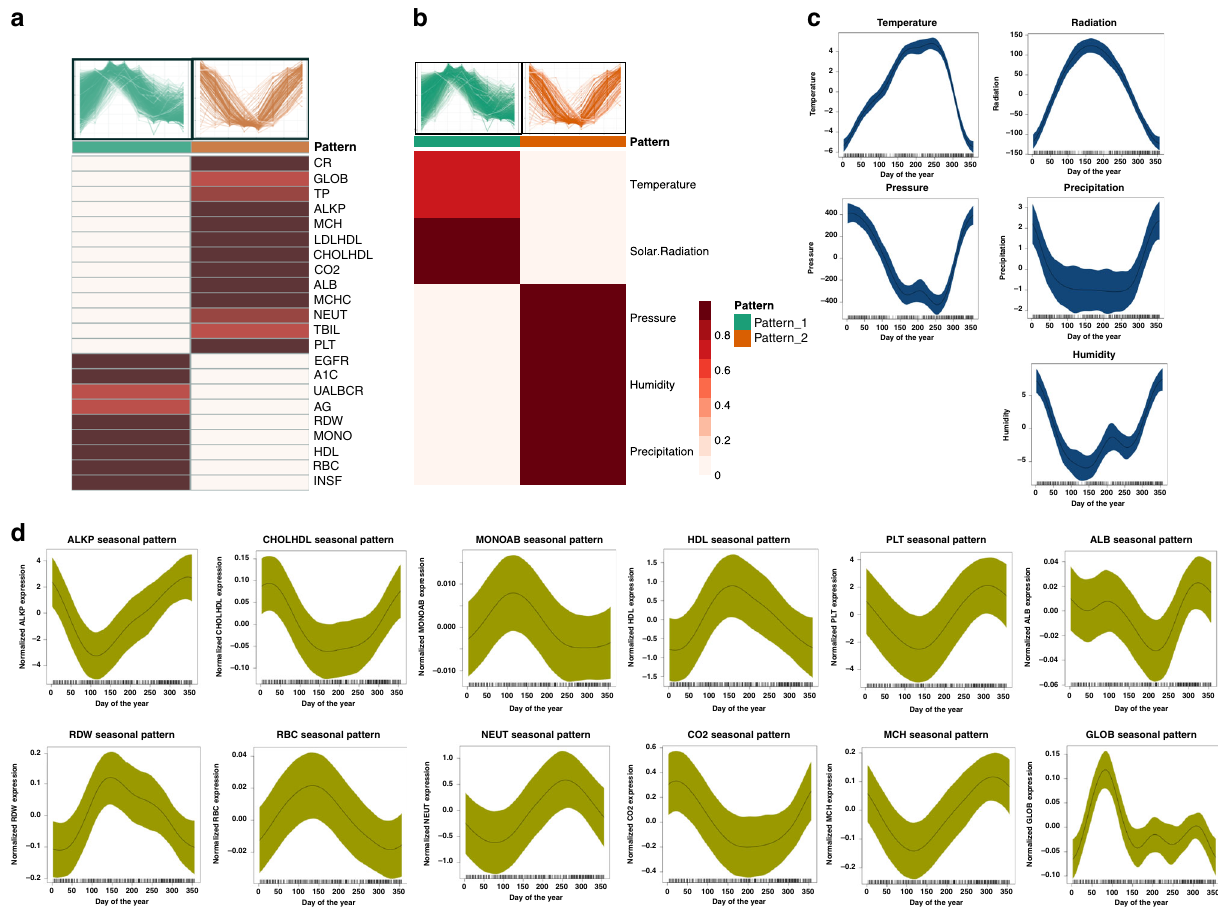
Fig. 3 Clinical lab tests and meteorological data correlate with omics seasonal patterns. Correlation of ( a ) clinical lab tests and ( b ) meteorological measurements with the two omics seasonal patterns are shown. The heatmap shows cluster membership values (which are on a scale of 0 and 1) based on existing cluster centroids. Seasonal patterns of ( c ) meteorological measurements and ( d ) clinical lab tests are shown (omics pattern one is shown in green color and omics pattern two is shown in orange color). The X -axis shows the days of the year (1 – 365 days) and Y -axis show the normalized measurement values. The shaded area represents 95% con fi dence bounds computed as ±1.96 standard deviation of model coef fi cients. Standard deviations were derived from a maximum likelihood fi